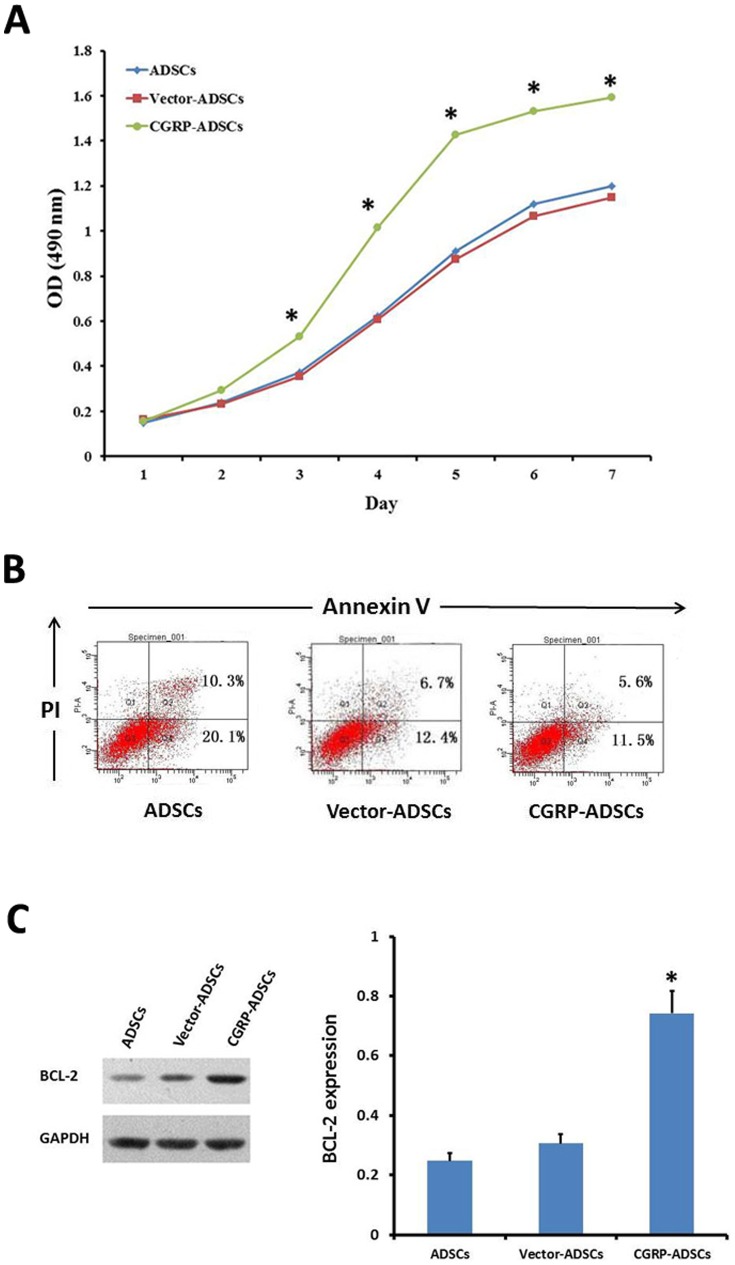
CGRP overexpression altered the characterization of ADSCs.(A) The growth curves showed that CGRP-ADSCs had a significantly higher proliferation than ADSCs or V-ADSCs. *p<0.05, CGRP-ADSCs group vs. controls. (B) Apoptosis was quantified through FACS analysis after staining with Annexin V and PI. The Annexin V+/PI− cells appeared early in the apoptotic process. The viable cells were Annexin V−/PI−. The quantitative analysis showed that the number of TUNEL-positive cells in CGRP-ADSCs was significantly decreased compared with ADSCs and V-ADSCs. (C) The expression of BCL-2 among all groups was detected on day 3. *p<0.05, CGRP-ADSCs group vs. controls.